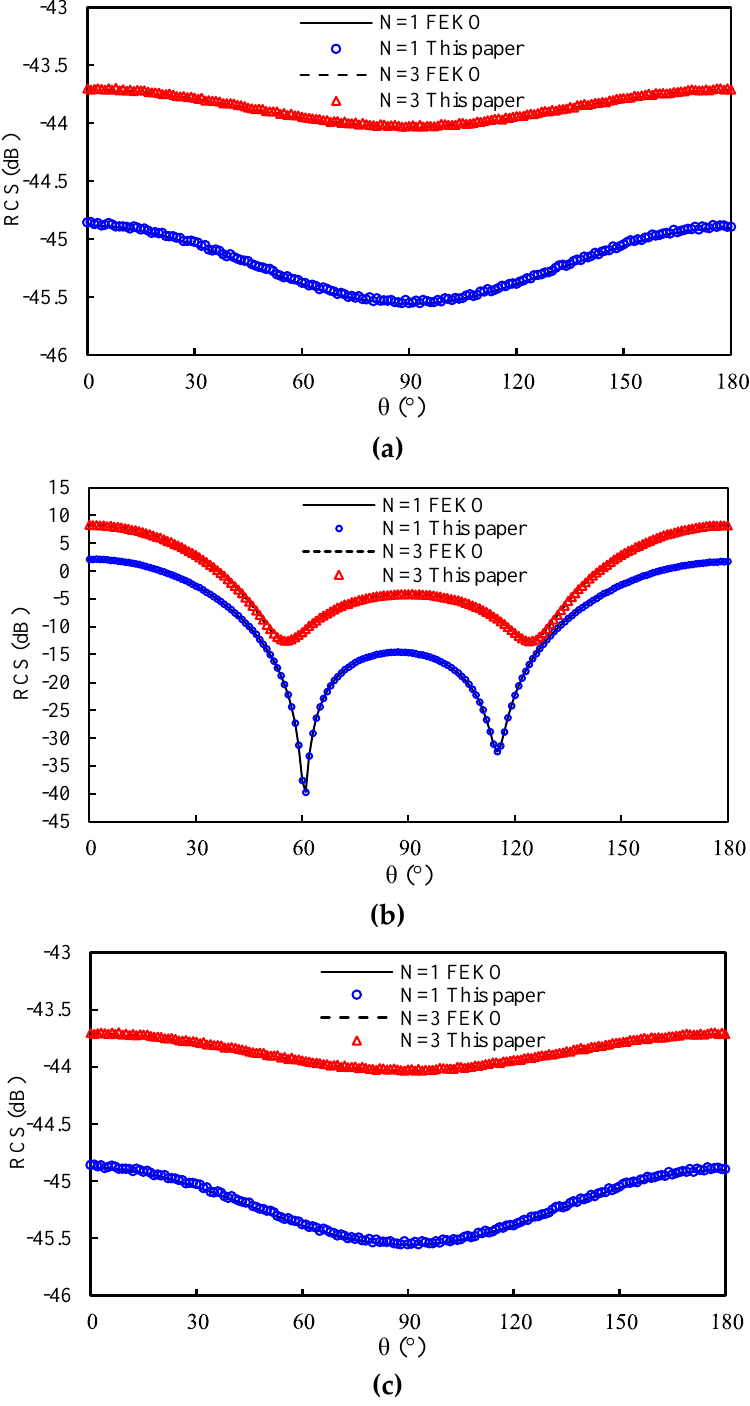
Figure 6. ϕ = 90 ◦ RCS: ( a ) 1.06 THz; ( b ) 7.2 THz; ( c ) 12.9 Figure 6. φ = 90° RCS: ( a ) 1.06 THz; ( b ) 7.2 THz; ( c ) 12.9 THz.